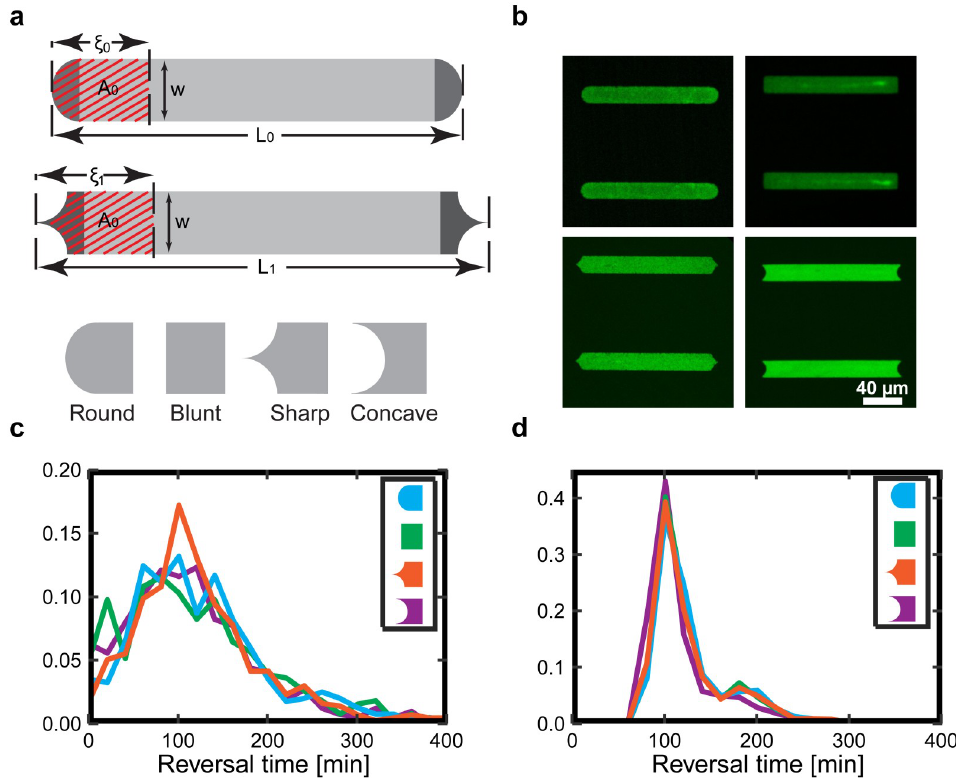
Fig 6. Effect of curvature on the repolarization time. ( a ) Schematic diagram of microlane geometry with four different tip shapes: blunt, concave, round, and sharp. The area of all microlanes and the reversal area A 0 are kept constant. ( b ) Exemplary fluorescent images of microlanes of width W = 20 μ m. ( c , d ) Distribution of cell reversal times ( Δ t) when reaching the microlane tips, for four different tip shapes. ( c ) Experimental reversal time distribution. ( d ) Simulated reversal time